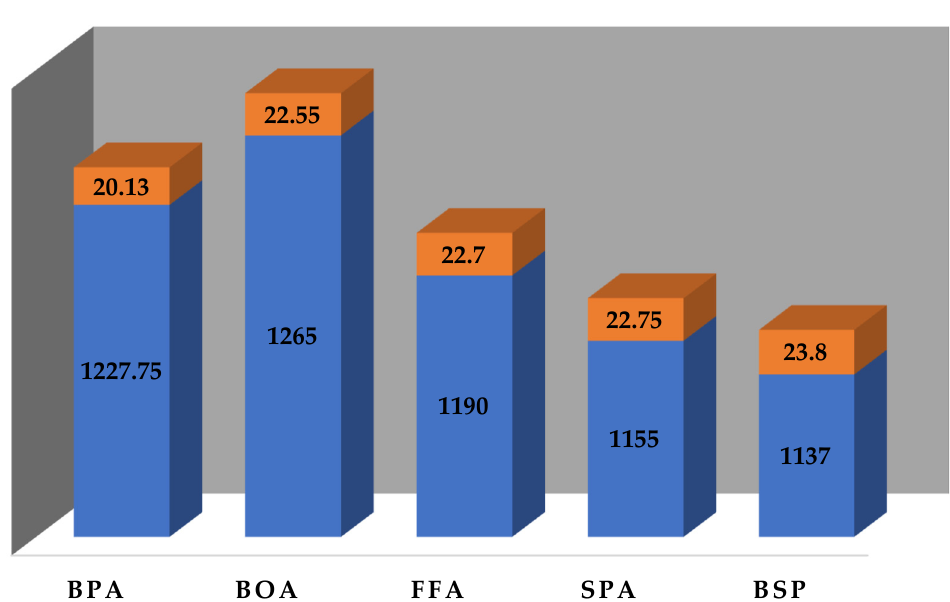
Figure 5. Monitored CO 2 concentration and RH across the workstations.